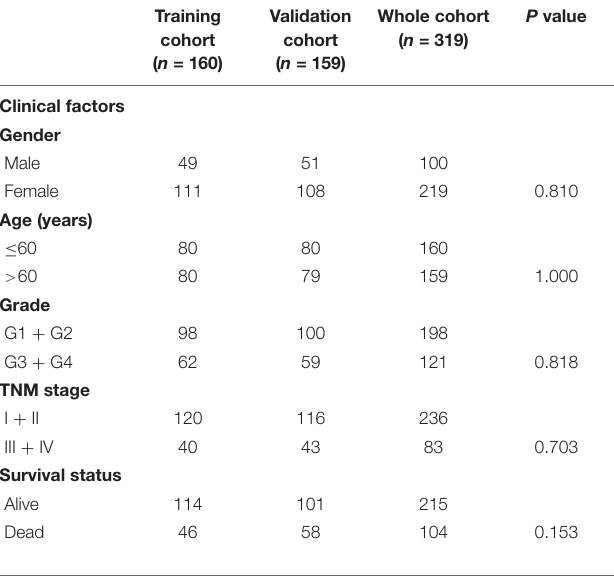
TABLE 1 | Clinical factors of patients with ICC.